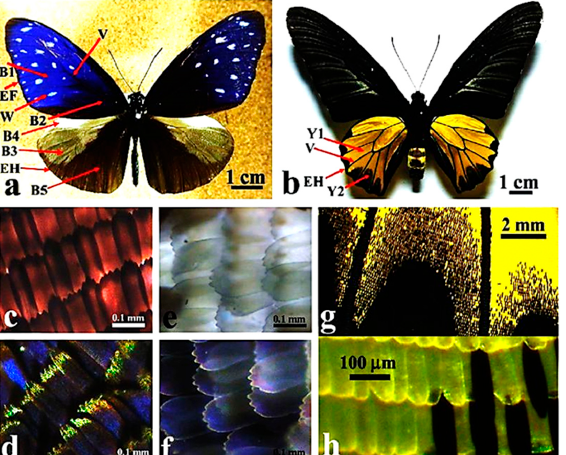
Figure 1. Dorsal side view of butterfly males of ( a ) Euploea mulciber Cramer and ( b ) Troides aeacus (Felder & Felder). Images of wing scales of E. mulciber observed at higher magnification under transmitted ( c , e ) and reflected ( d , f ) light conditions, from the blue ( c , d ) and white ( e , f ) regions indicated by B1 and W, respectively, in ( a ). Images of wing scales (indicated by Y2) of T. aeacus observed at variable magnification under transmitted ( g , h ) light conditions. The changes in color observed in E. mulciber in response to different illumination conditions have been explained with multiple interference effects induced by the layered arrangement of the brown scale cuticle, acting similarly to an optical diffraction grating. In T. aeacus , the yellow color does not show changes under different illumination conditions, consistently with the absence of multilayered rib-like wing scales and the consequent inability to produce scattering effects. Yellow is thus a real intrinsic color due to the presence of the pigment papilliochrome. Bars: 1 mm ( a,b ), 100 µ m ( c – f ), 2 mm ( g ). Modified from